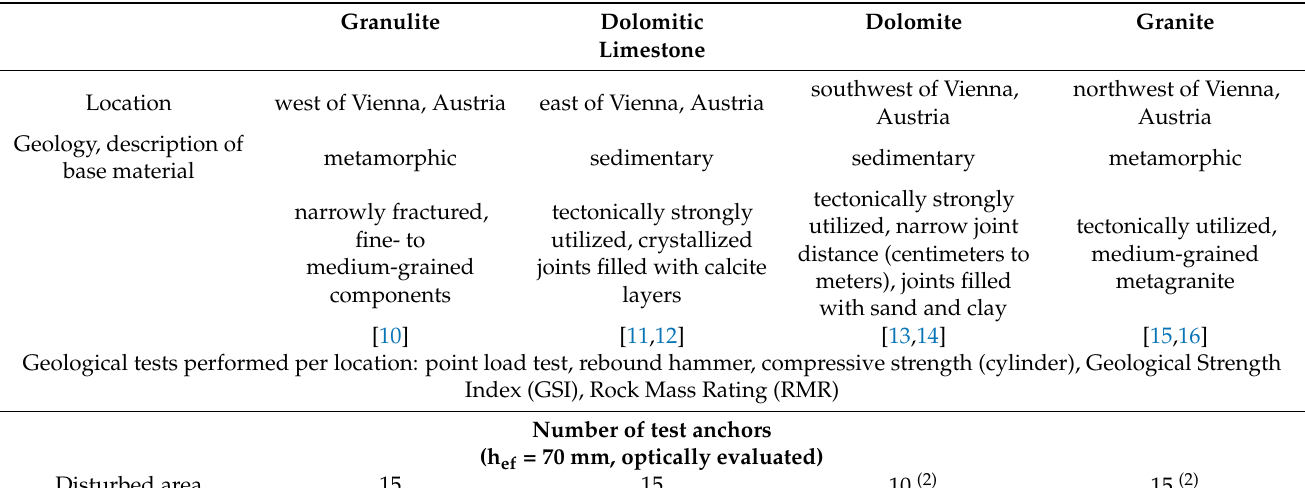
Table 1. Overview of the conducted test program.